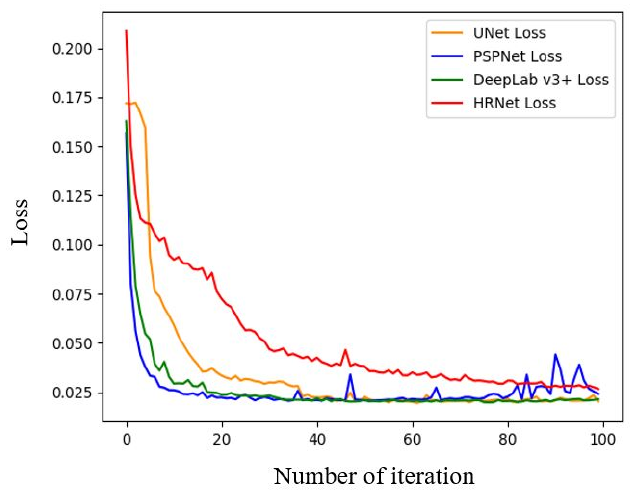
Figure 14. Validation dataset losses of various semantic segmentation models.